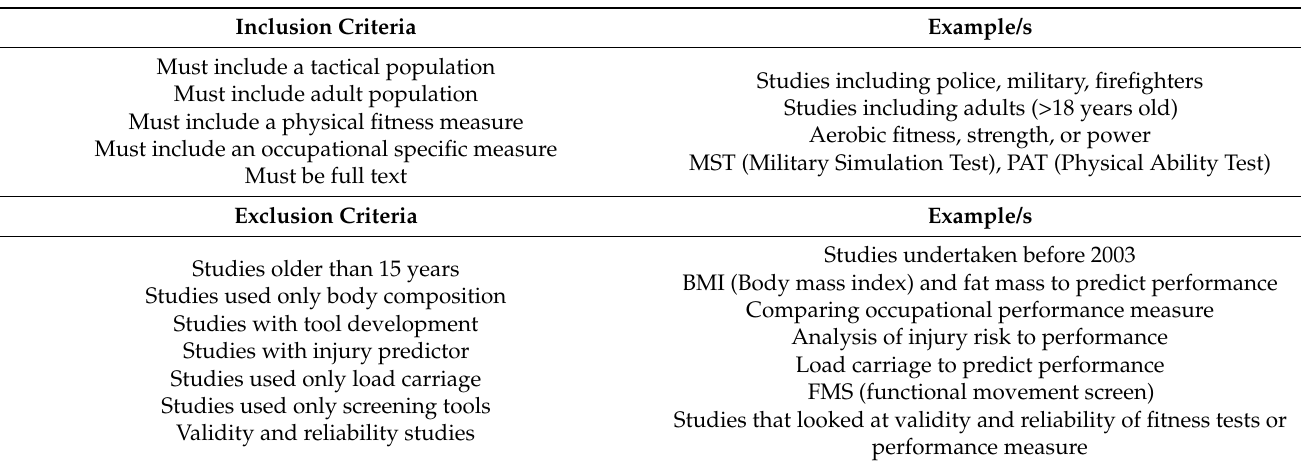
Table 2. Inclusion and exclusion criteria and